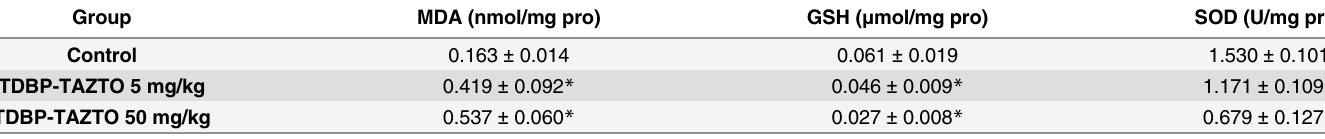
Table 2. Effects of TDBP-TAZTO on oxidative stress markers in